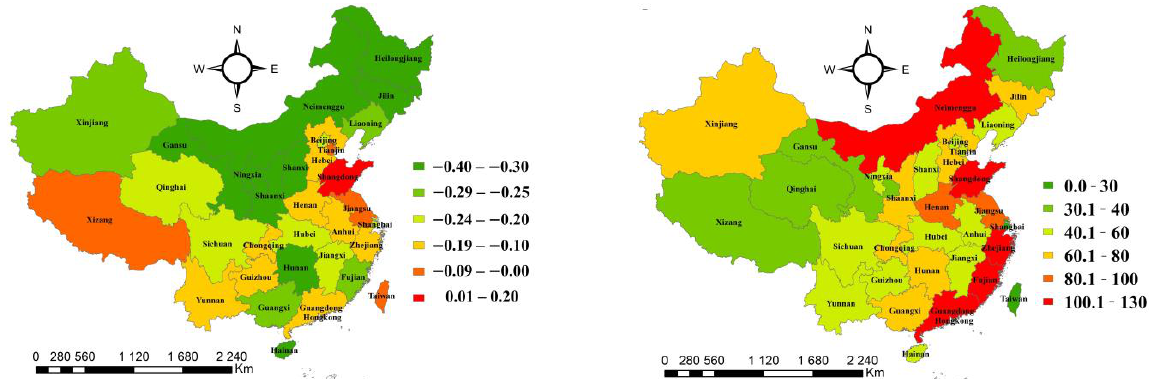
Figure 2. Rates of changes in wetland areas ( left ) and average GDP per capita ( right ) in China during the three decades